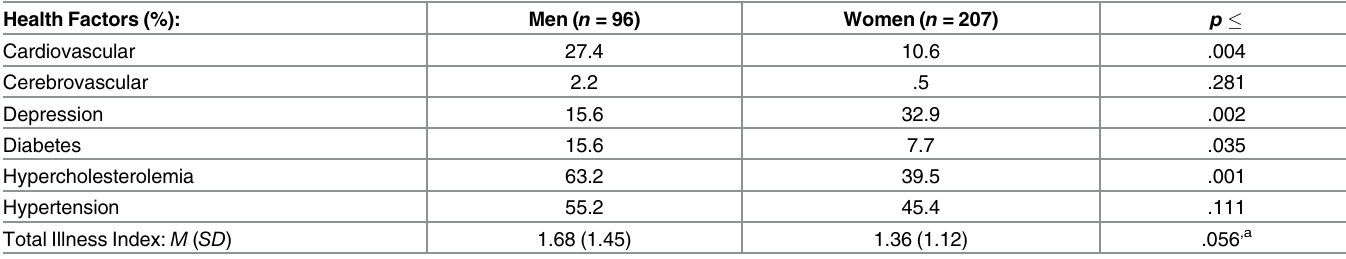
Table 3. Group differences in health risk characteristics by sex.